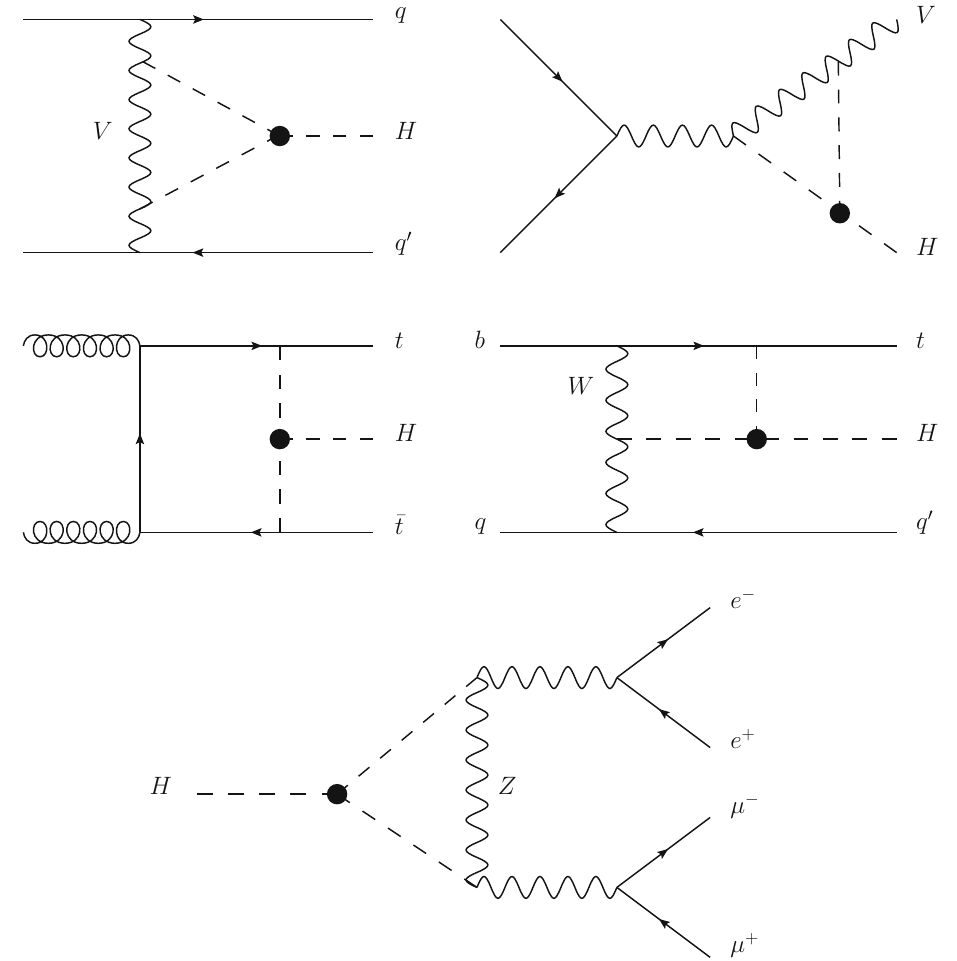
Fig. 1 Representative one-loop diagrams in single Higgs processes with anomalous trilinear coupling. Differential information on gg F requires the calculation of EW two-loop amplitudes for Hj production, which is not yet feasible with the current technology